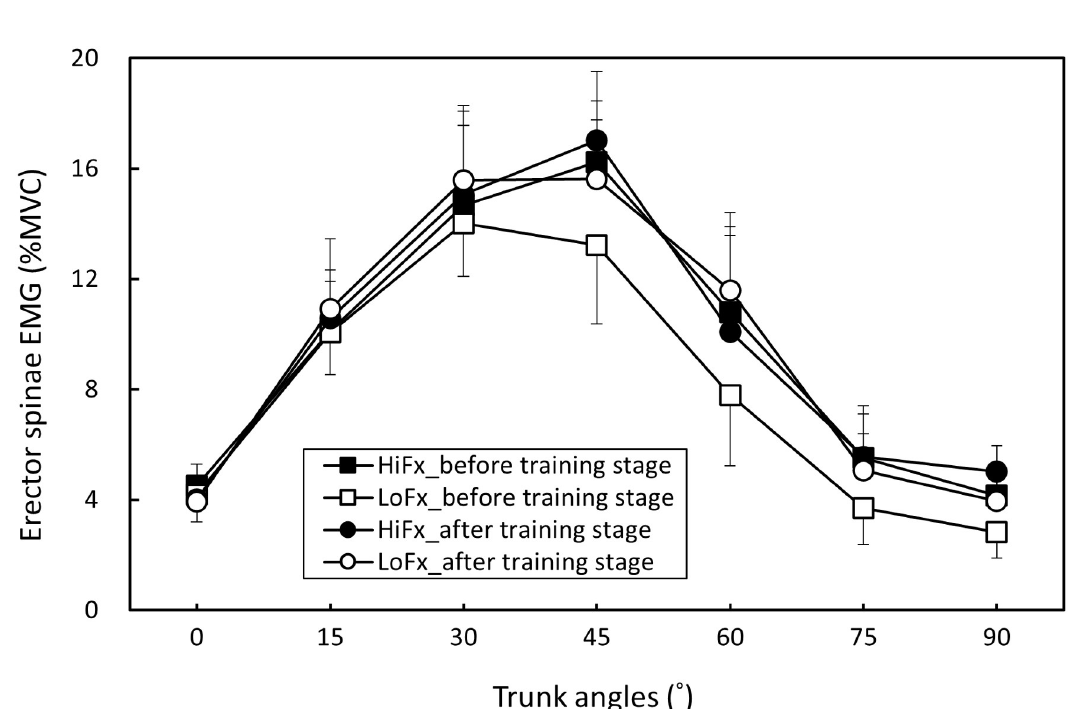
Fig 3. Changes in erector spinae activation (mean and standard deviation) in the two participant groups before and after flexibility training stage (HiFx: High flexibility; LoFx: Low